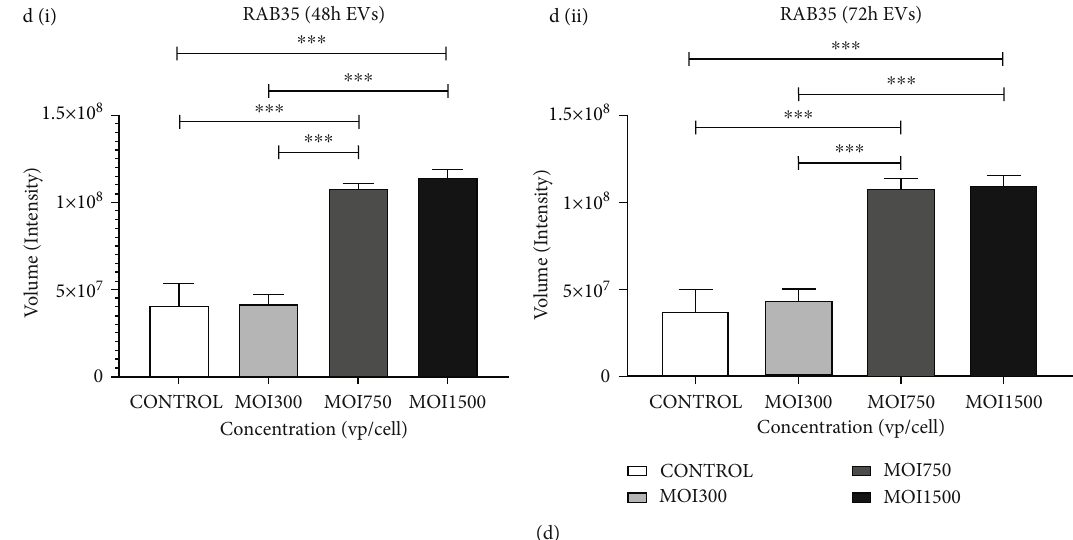
Figure 3: The e ff ect of HAdV3 infection on intracellular tra ffi cking GTPase. (a) Dot blot analysis showing expression of Rab5, Rab7, and Rab35 after 48h and 72h infection. EVs were probed for the presence of Rab proteins. (b) (i) Graphs showing quanti fi cation of Rab5 level after 48 h and (ii) 72h of infection. (c) (i) Rab7 after 48 h and (ii) 72h of infection. (d) (i) Rab35 after 48h and (ii) 72 h of infection. Data show the mean ± SEM from three independent experiments. Dots shown in the fi gure are representative of four independent experiments. Data shows the mean ± SEM from four independent experiments and performed using one-way analysis of variance (ANOVA) with Tukey post hoc analysis. Statistical signi fi cance is indicated by the mean ± SD as follows: ∗ p < 0 : 05 , ∗∗ p < 0 : 01 , ∗∗∗ p < 0 : 001 , and ∗∗∗∗ p < 0 : 0001